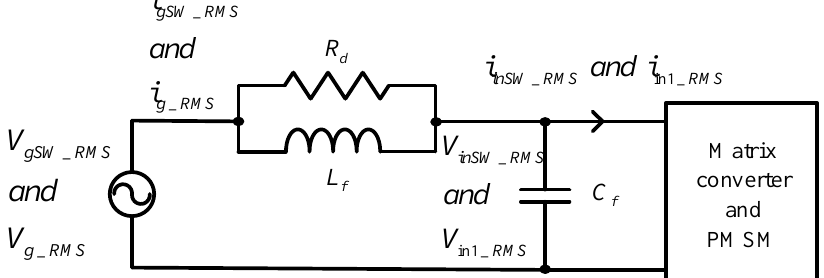
Figure 4. The single-phase equivalent circuit of the input filter for the matrix converter.